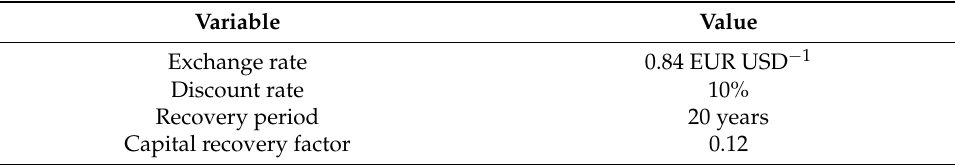
Table 8. Economic